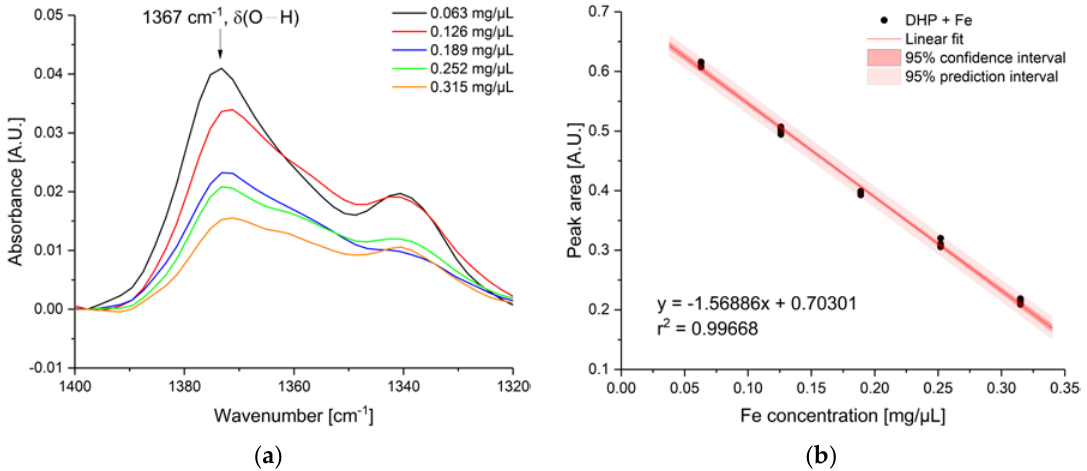
Figure 6. ( a ) IR spectra of the decreasing IR absorption feature of DHP from O–H deformation vibration at 1367 cm − 1 used for quantitative evaluation; ( b ) Established linear calibration function. Five repetitive measurements of each Fe concentration were recorded in the range from 0.063 mg / µ L to 0.315 mg / µ